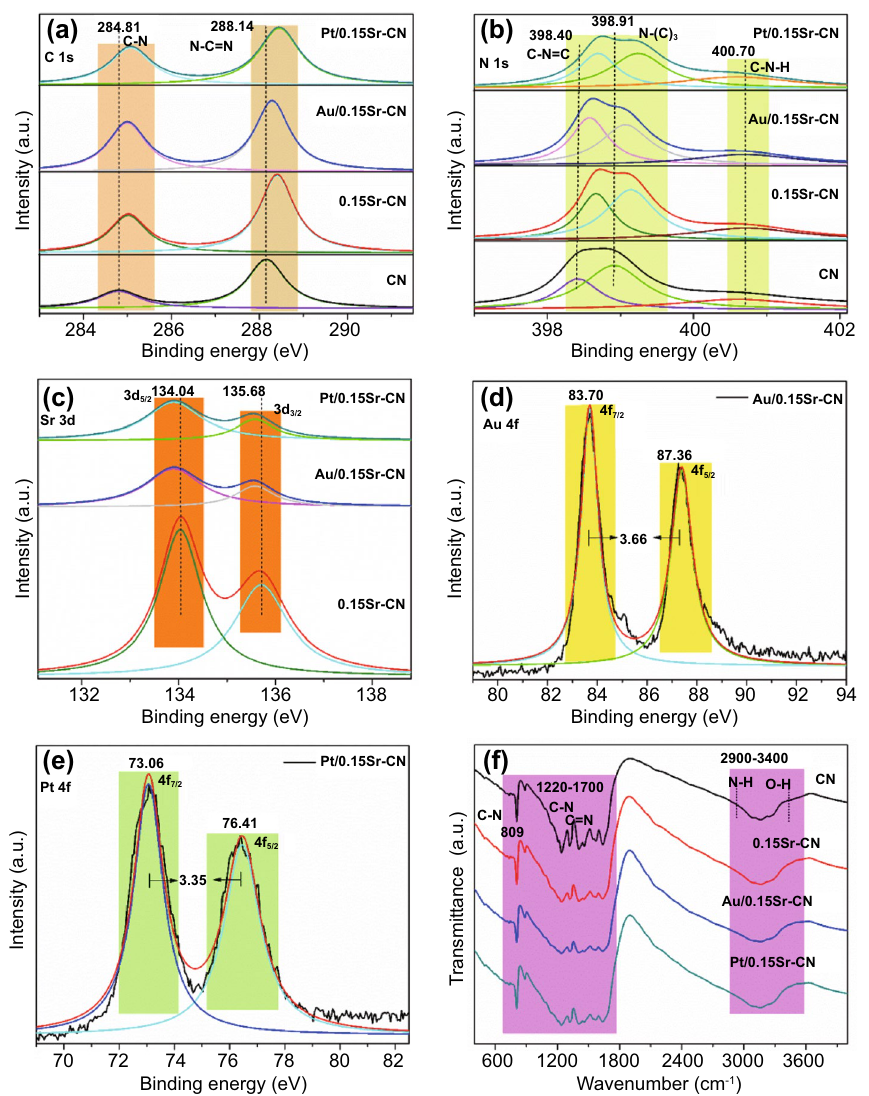
Fig. 5 High resolutions of a C 1 s-XPS and b N 1 s-XPS of CN, 0.15Sr-CN, Au/0.15Sr-CN, and Pt/0.15Sr-CN, c Sr 3d XPS of 0.15Sr- CN, Au/0.15Sr-CN, and Pt/0.15Sr-CN, d Au 4f XPS of Au/0.15Sr-CN, e Pt 4f XPS of Pt/0.15Sr-CN and f FTIR spectra of CN, 0.15Sr-CN, Au/0.15Sr-CN, and